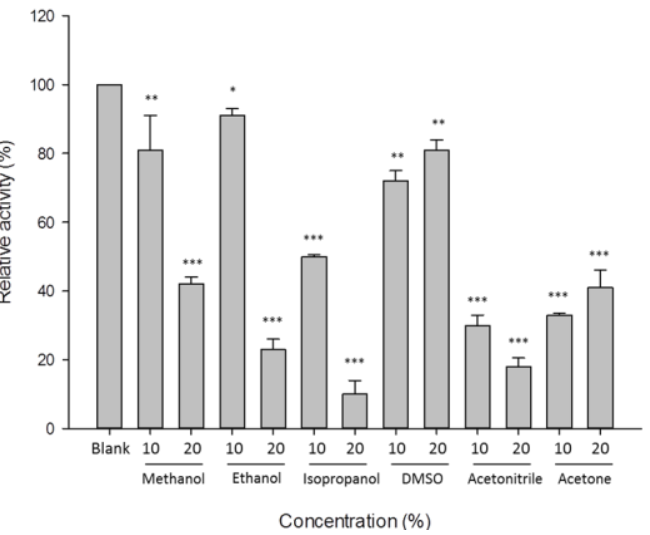
Figure 5. Effect of organic solvents on β -1,3-glucanase from Y. lipolytica transformant (pYLSC1- 13g ). Data: mean ± SE from triplicate experiments (Student’s t -test P values: * p < 0.05; ** p < 0.01; *** p < 0.001). 1 mM Zn 2+ and Hg 2+ further inhibited enzyme activity.